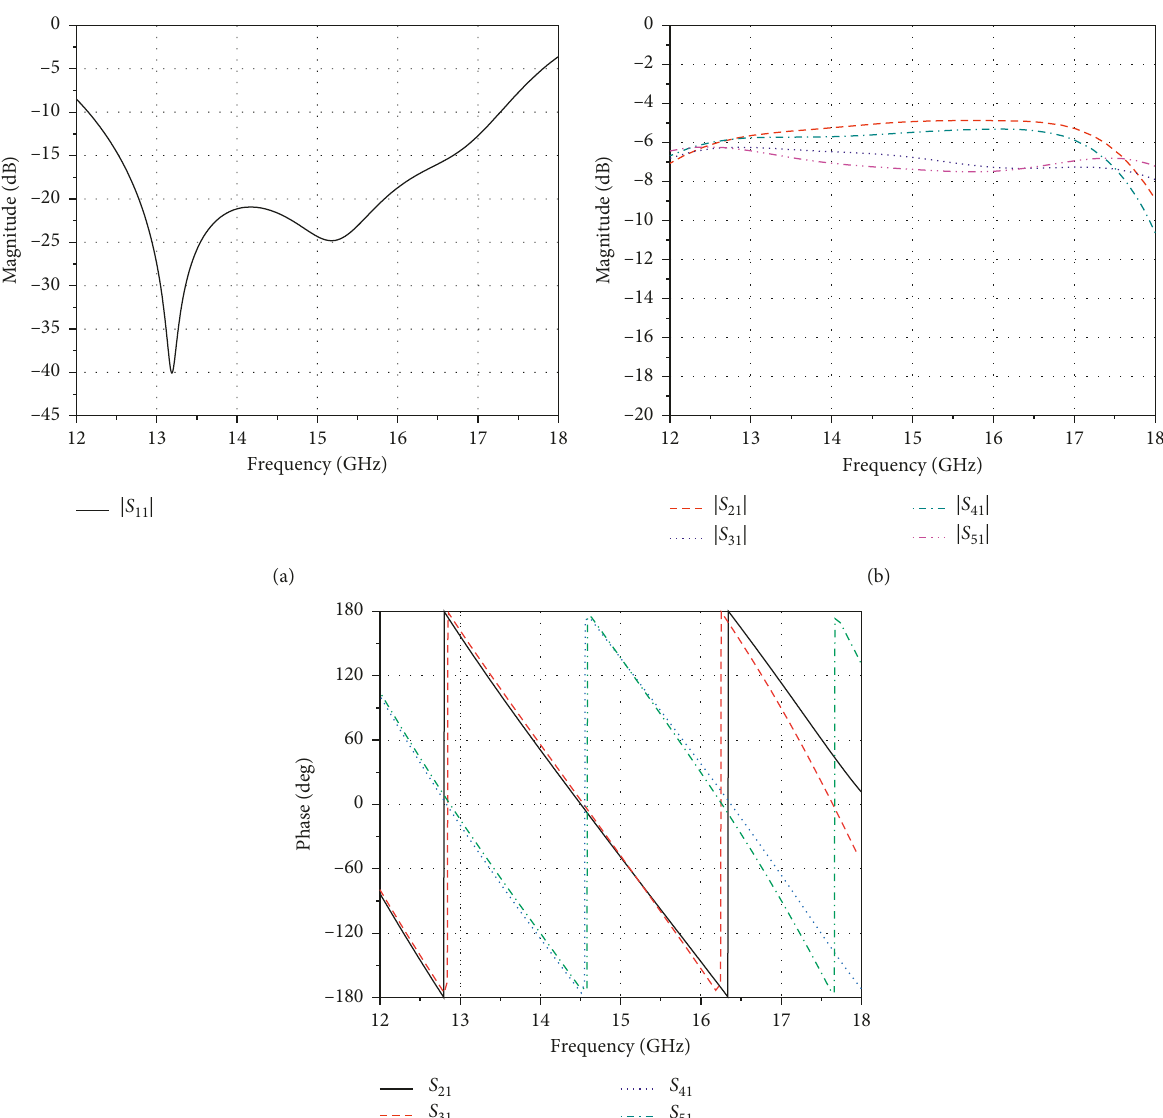
Figure 10: Simulated results of the two-layer feeding network of 2 × 2 subarray. (a) S